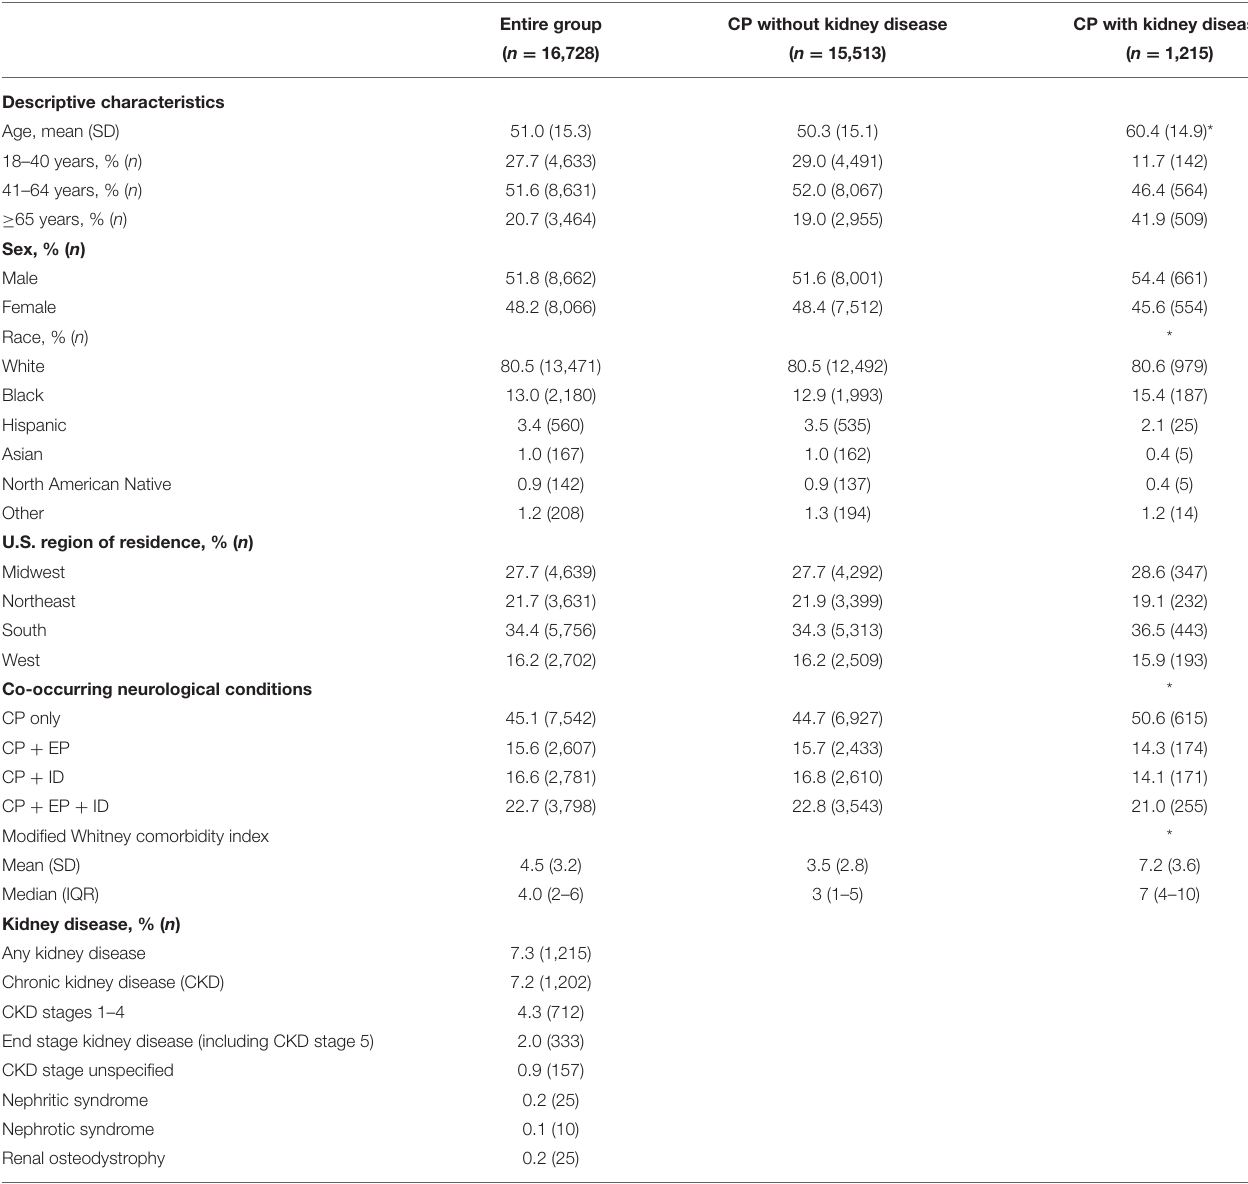
TABLE 1 | Baseline descriptive characteristics and prevalence of kidney disease for adults with cerebral palsy (CP) with or without kidney disease. Entire group CP without kidney disease CP with kidney